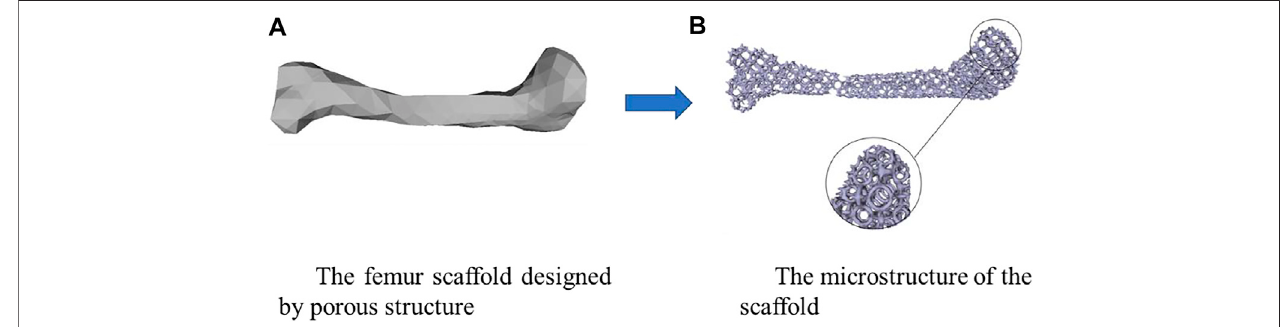
FIGURE 1 | An example of designing the scaffold using the porous microstructure (adapted from Guo et al., 2018).